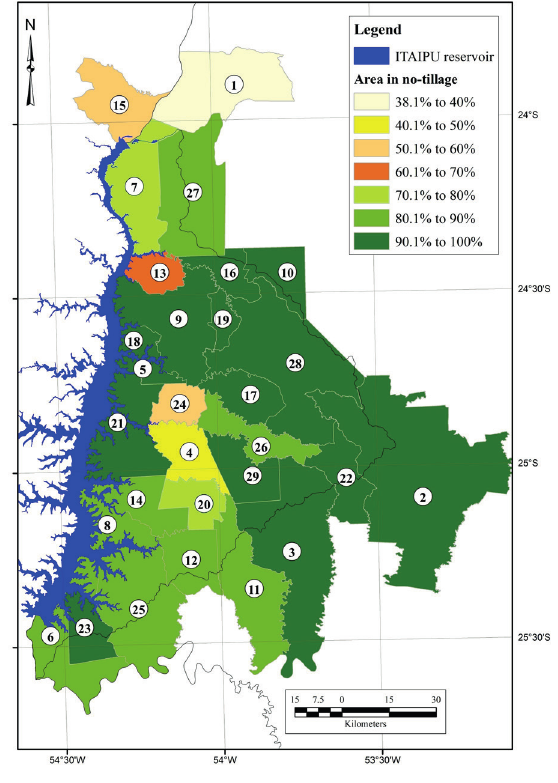
Figure 2 - Percentage of the area used with no-tillage (PD) in areas of annual crops in the Paraná Watershed III (PB3).